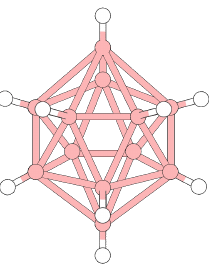
Figure 6. Schematic view of the icosahedral [B 12 H 12 ] 2 − . Pink spheres denote boron atoms and white spheres denote hydrogen